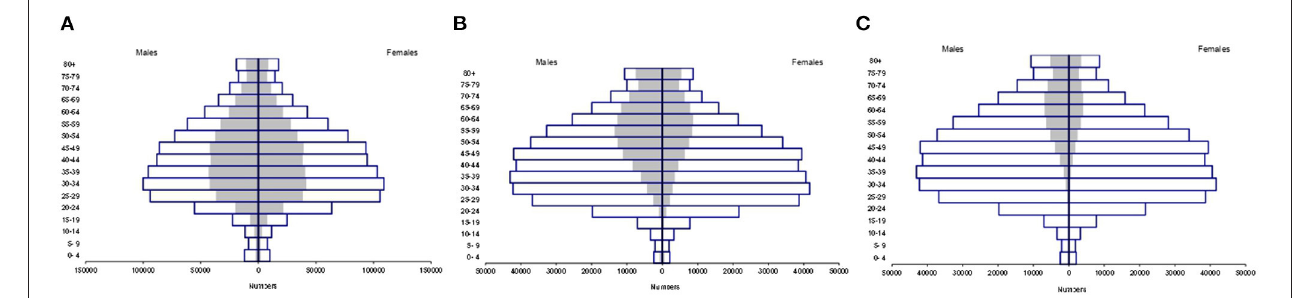
FIGURE 1 | Distribution according to age group and sex, in Mexico. (A) Distribution of suspected cases (white bar) and positive cases (gray bar) according to age group and sex, in Mexico. (B) Distribution of positive cases (white bar) and hospitalized cases (gray bar) according to age group and sex, in Mexico. (C) Distribution of patients who died from SARS Cov-2 by age group and sex in Mexico. Positive cases (white bar) and deaths (gray